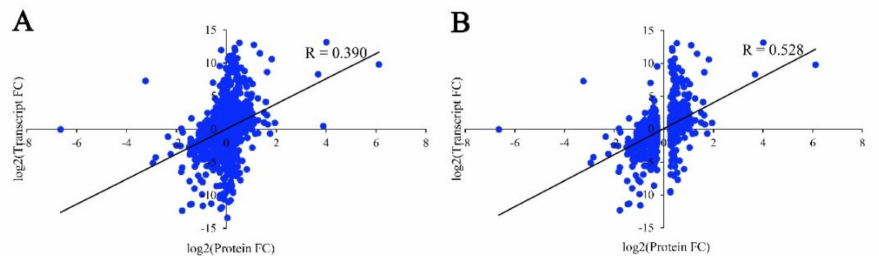
Figure 5. Correlation between the expression of proteins and mRNAs. ( A ) Correlation of all quan- tified proteins and their corresponding mRNAs. ( B ) Correlation of DEPs and their corresponding mRNAs. “R” represents the correlation coefficient calculated by the Pearson correlation test, and “FC” represents fold